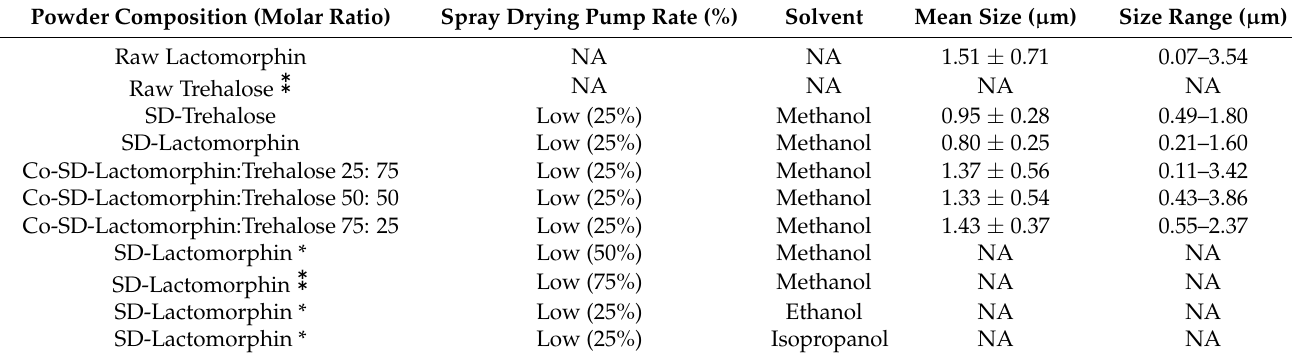
Table 2. Particle sizing using image analysis on SEM micrographs ( n ≥ 100 particles).